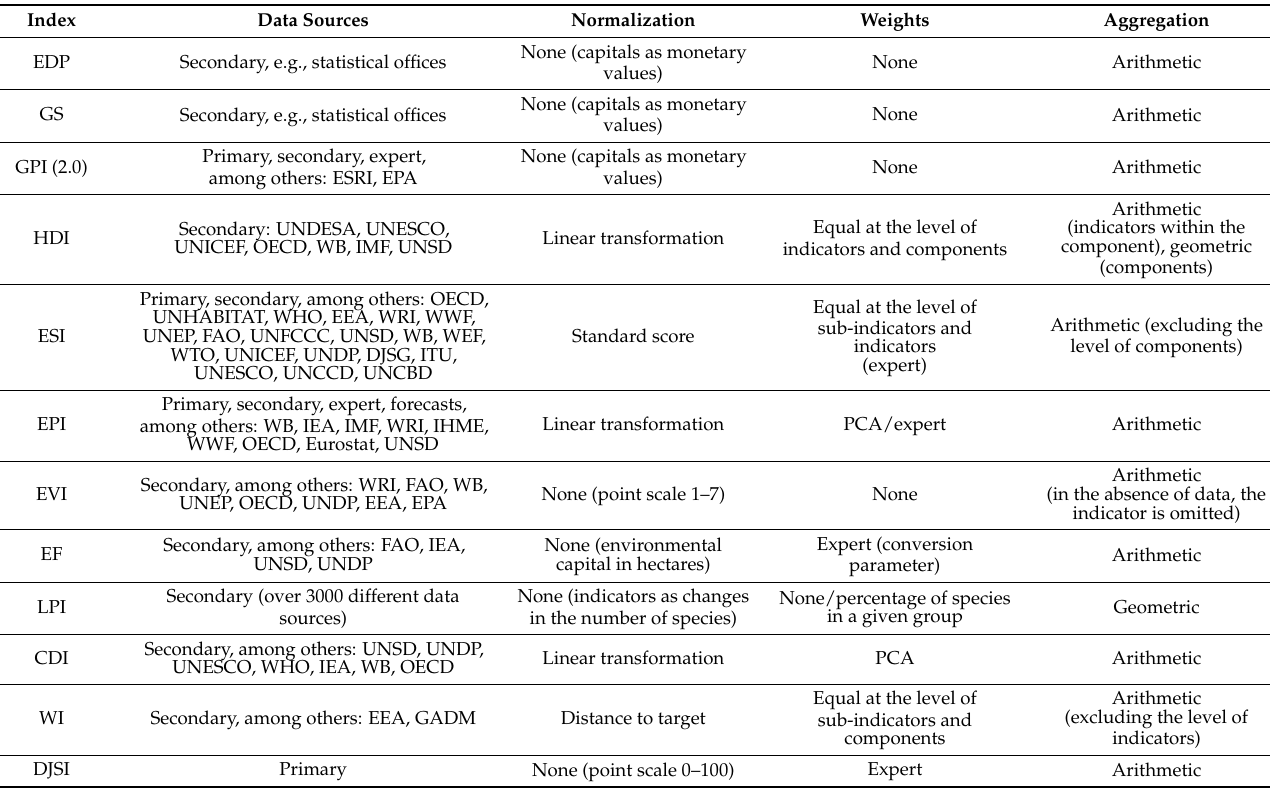
Table 3. Comparison of selected sustainability indices (part